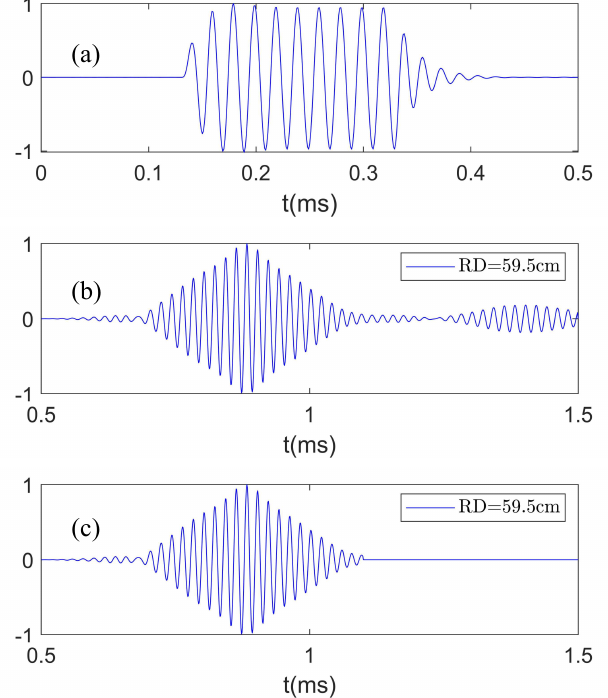
Figure 6. ( a ) Reference signal for a vertical array measurement; ( b ) the received waveform of a hydrophone with a source depth of SD = 55 cm (temporal correlation between the received sound pressure and the reference signal); ( c ) the truncated waveform adopted for identifying Scholte